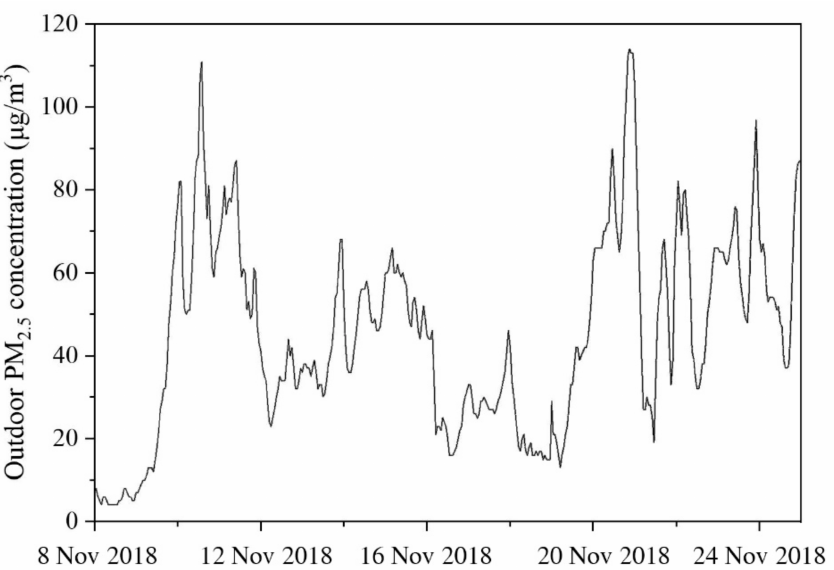
Figure 2. Outdoor PM 2.5 concentration during